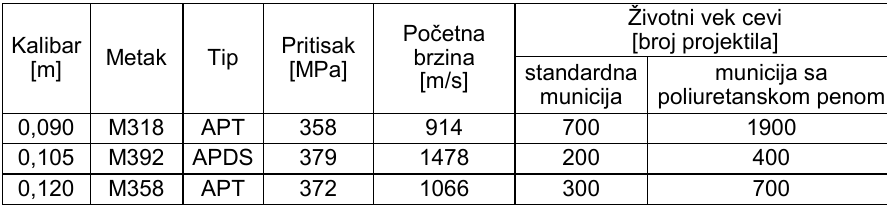
Effects of polyurethane foam on the barrel lifetime